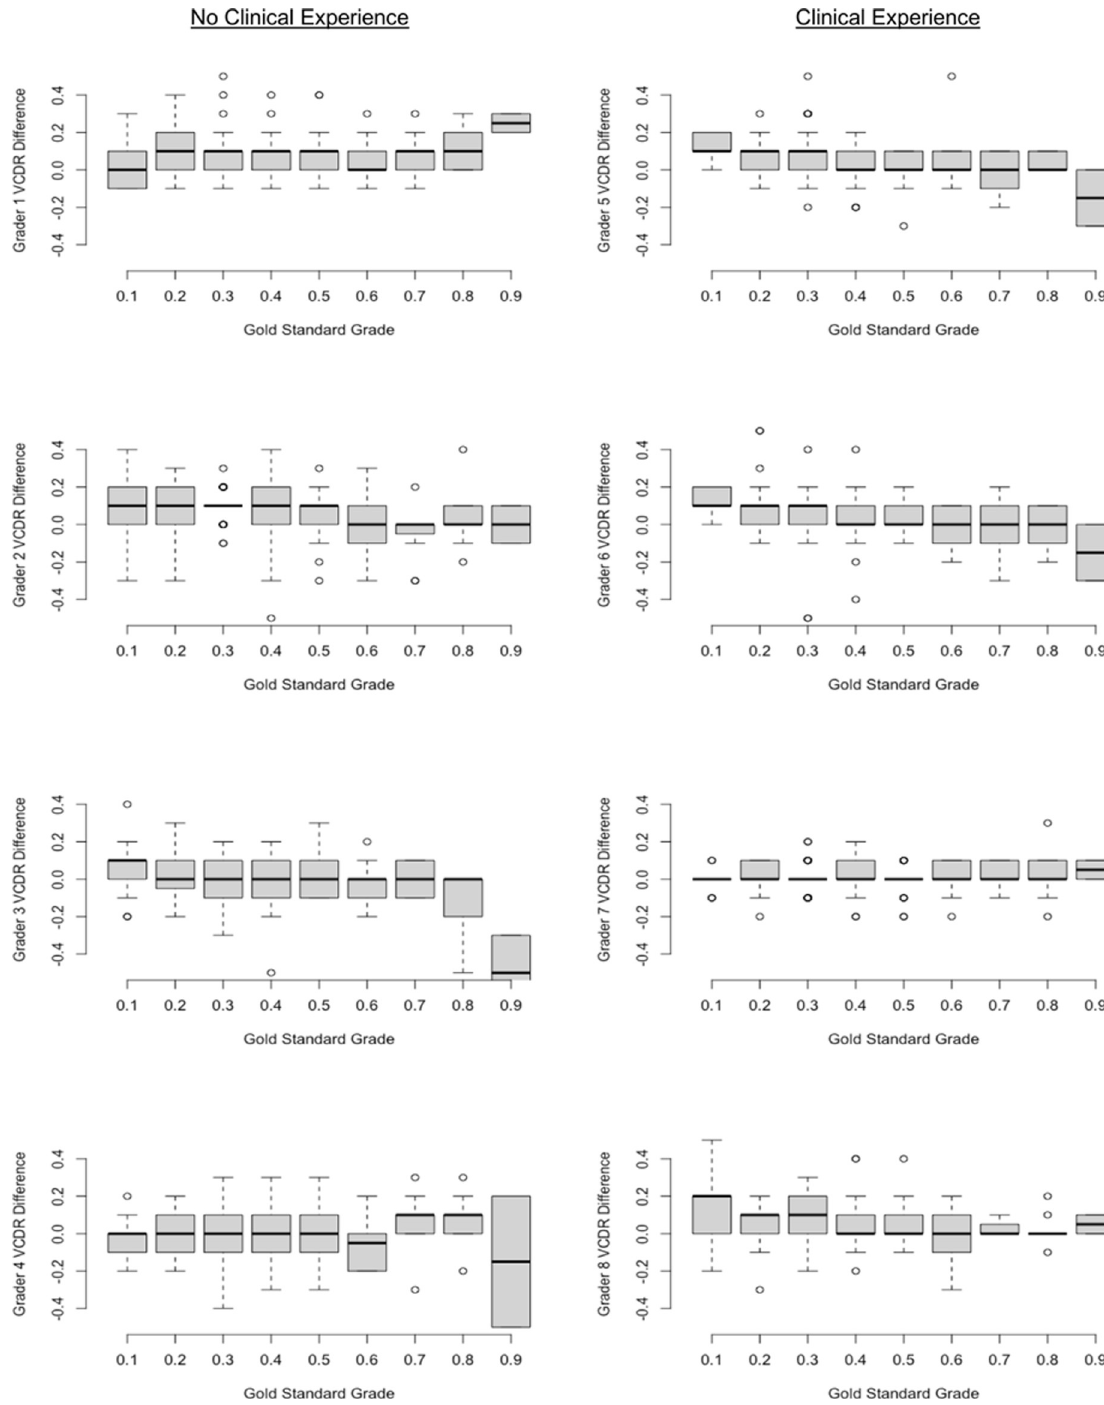
Fig 3. Difference of visual to software-assisted grading across different VCDR Values. Positive numbers mean that the program overestimated visual inspection, whereas negative numbers mean that the program underestimated visual inspection.